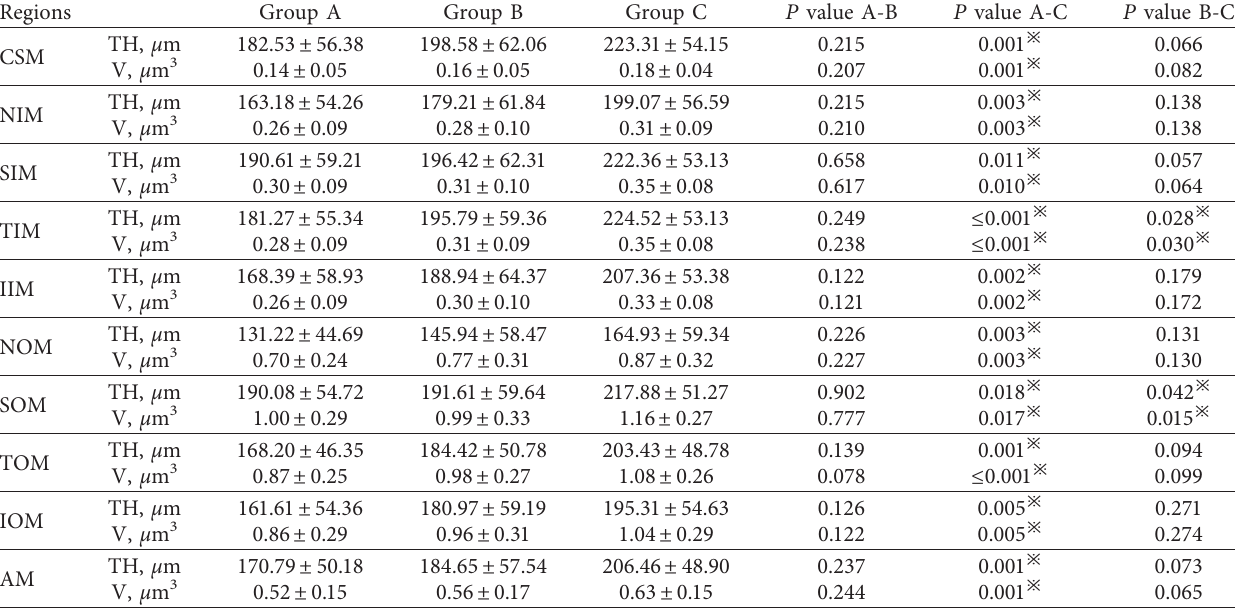
Table 2: Comparisons of macular choroidal thickness by EDI-OCT in three